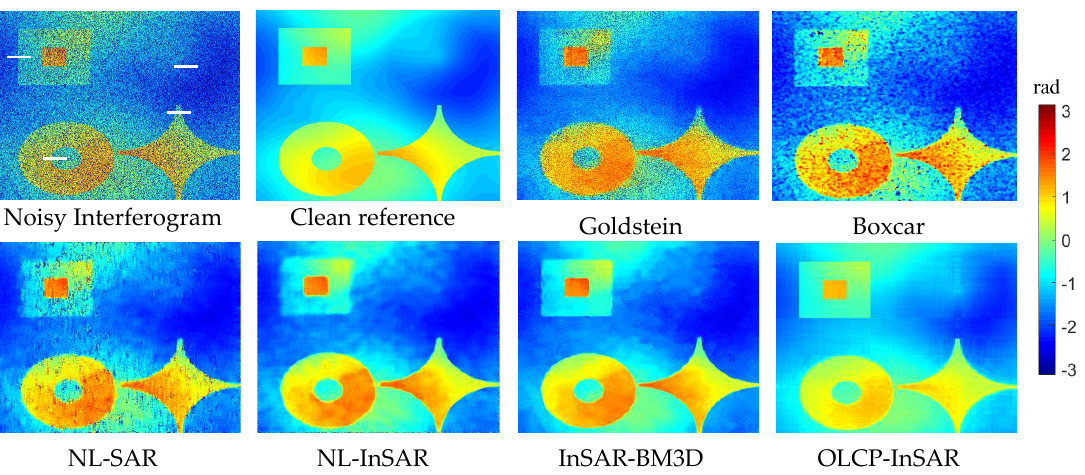
Figure 12. The result of filters operating on an interferogram. The white short line on the noisy interferogram is the selected profile and the filtered results of these profiles are shown in Figure 13. Table 3. MSE of a filtered interferogram with different noise conditions.